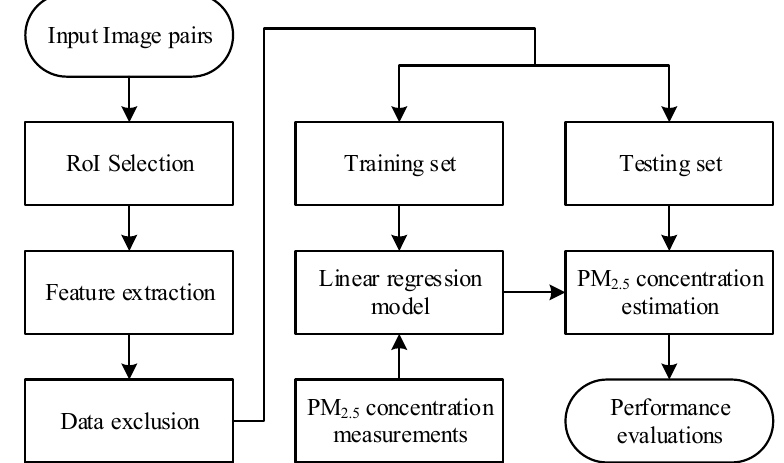
Figure 1. A block diagram of the proposed approach.